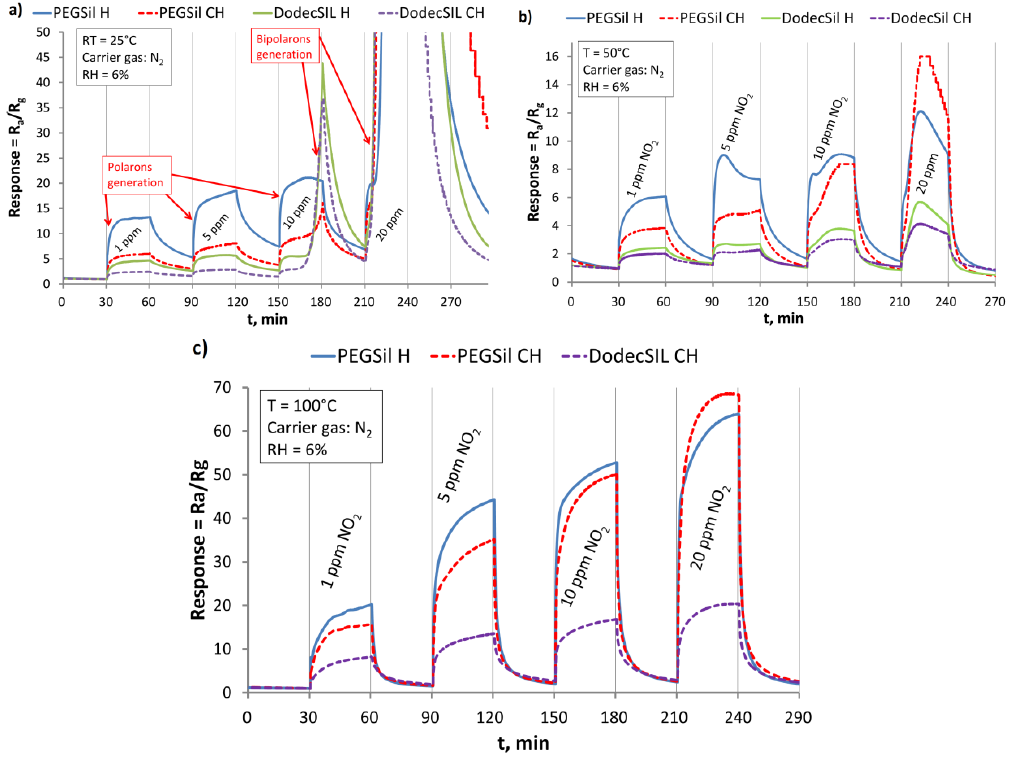
Figure 3. Sensor responses to different nitrogen dioxide (NO 2) concentrations at ( a ) RT = 25 °C; ( b ) 50 °C; ( c ) 100 °C.